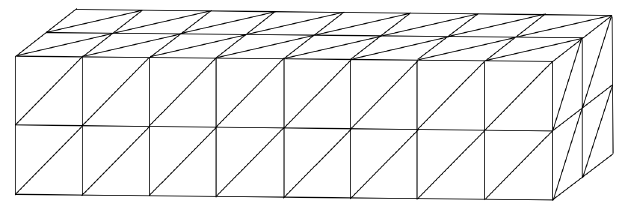
Figure 7. Boundary discretization for 1D